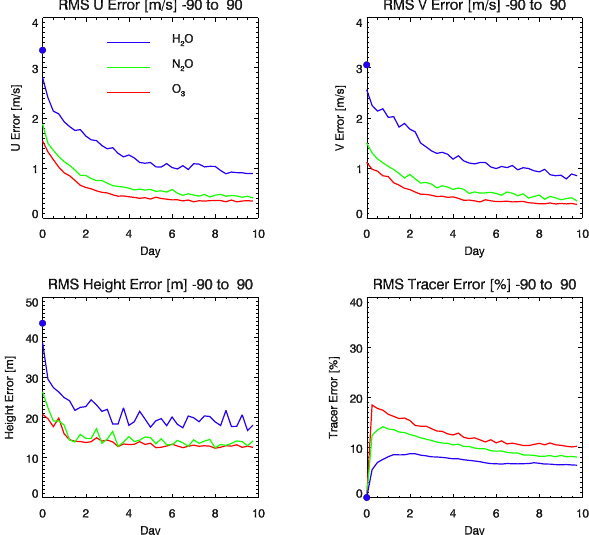
Fig. 7. Global RMSE for zonal wind, meridional wind, height, and tracer as a function of time for the MLS experiment: O 3 (red), N 2 O (green), and H 2 O (blue). Units are ms − 1 for zonal and meridional wind, m for height, and tracer % relative to σ ob . Circles indicate the initial global RMSE. Table 2. Specifications for select assimilation experiments used in this paper. Wind extraction potential (WEP) is percentage of poten- tial global vector wind reduction (see text for details). For the WEP after 10 days (last column), the value shown is the average value over the past four cycles. Note that ppmv refers to parts per million by volume.